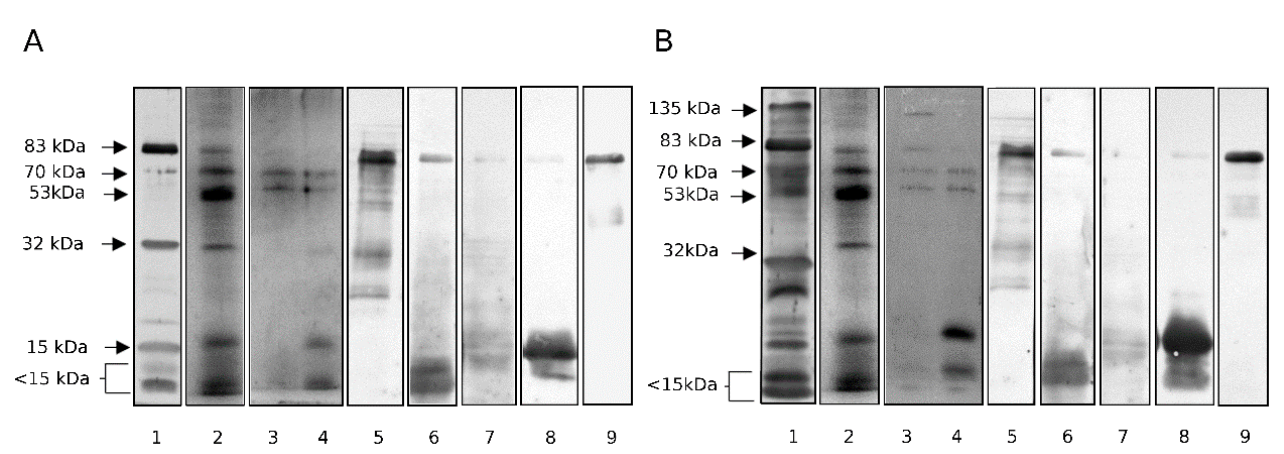
Figure 4. Protein and immunoreactivity patterns of the lectin affinity chromatography isolates. Lane 1: lectin probed whole seminal plasma; 2: silver stained whole seminal plasma; 3: 0.2 M GalNAc released glycoproteins, silver stained; 4: Gly-HCl buffer released glycoproteins, silver stained; Lanes 5–9: immunoreactivity of the isolates; 5: a-FN; 6: a-SEMG1; 7: a-SEMG2; 8: a-PIP; 9: a-LTF. ( A )—VVL-agarose column, ( B )—MPL-agarose column.